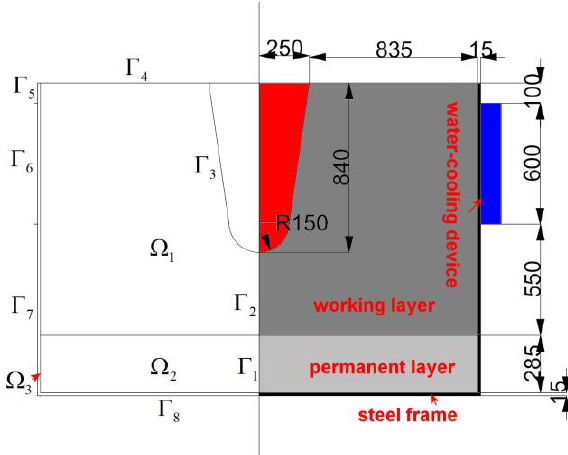
Figure 3. Computational domain and schematic diagram of the cross-section in the trough in the initial stage of a unit campaign cycle (unit: mm).